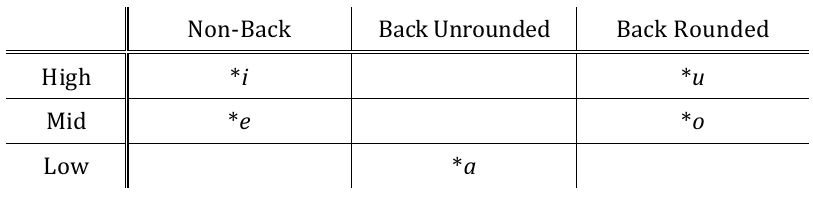
Table 2. Proto-Mojeño